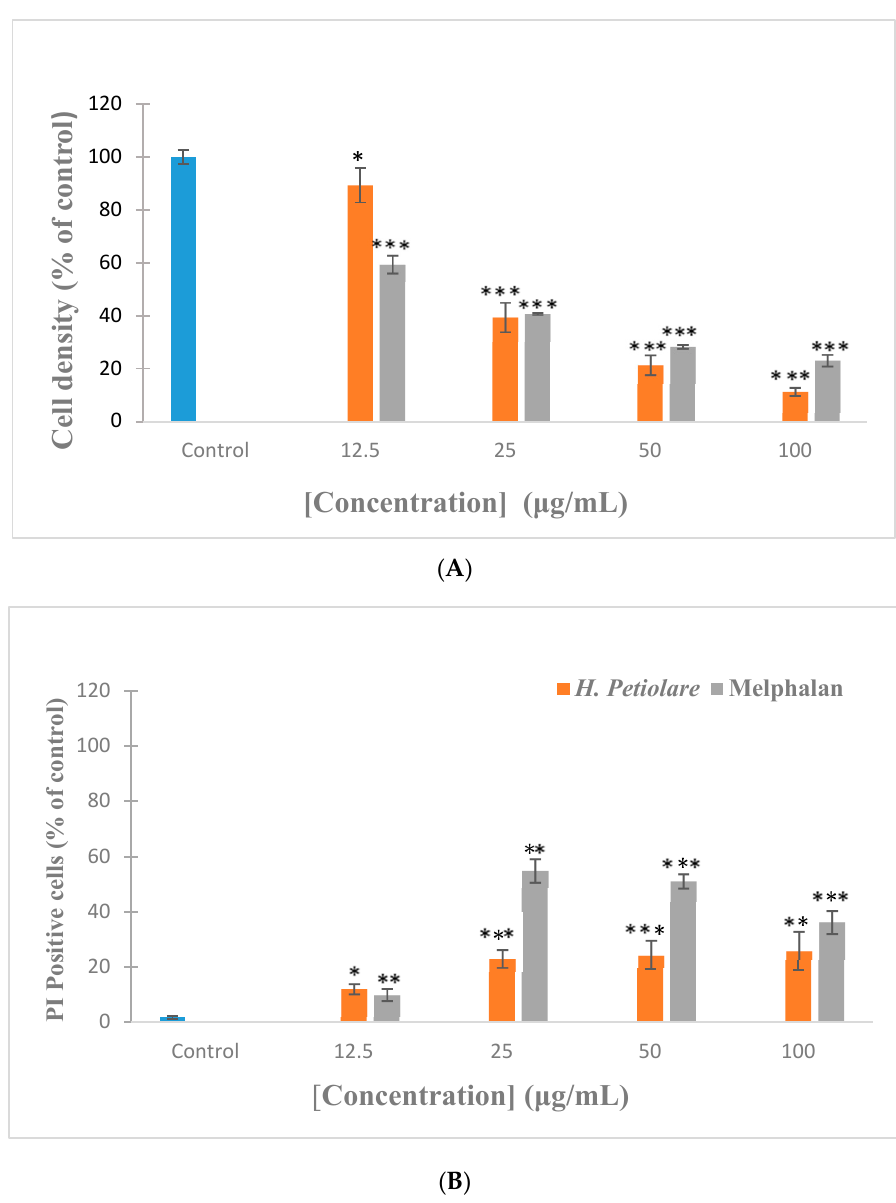
Figure 1. Cytotoxicity of H. petiolare methanol extract towards mouse melanoma cells (B16F10). ( A ) Cell density represents the number of nuclei stained with Hoechst and is expressed as a percentage of the untreated control. ( B ) Cell death is quantified as the percentage cells which stain positive for propidium iodide (PI). Melphalan was included as a positive control. Data are expressed as the mean ± SD, n = 3. * p < 0.05, ** p < 0.01 and *** p < 0.001 compared to control.